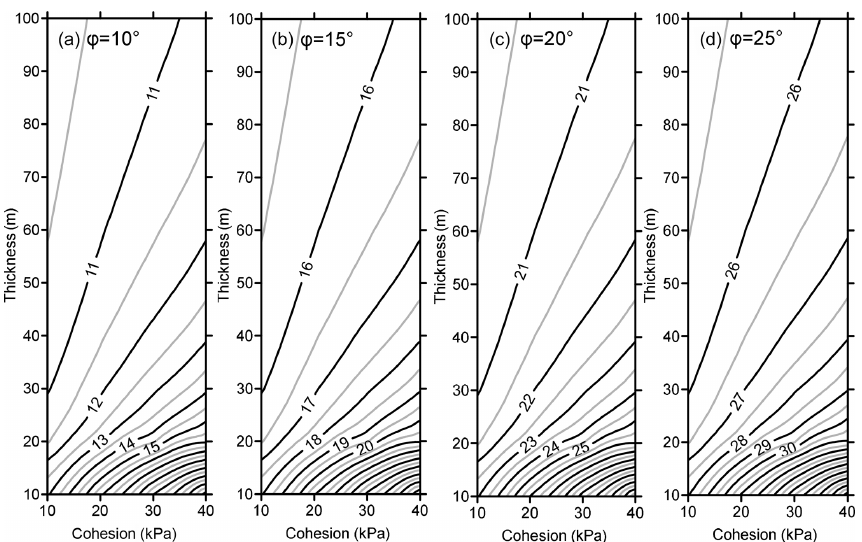
Figure 4. Contour maps for the slope angle θ 1 of slide surface that denotes the boundary between the driving and resisting sections under various shear strength parameters and slide mass thickness.